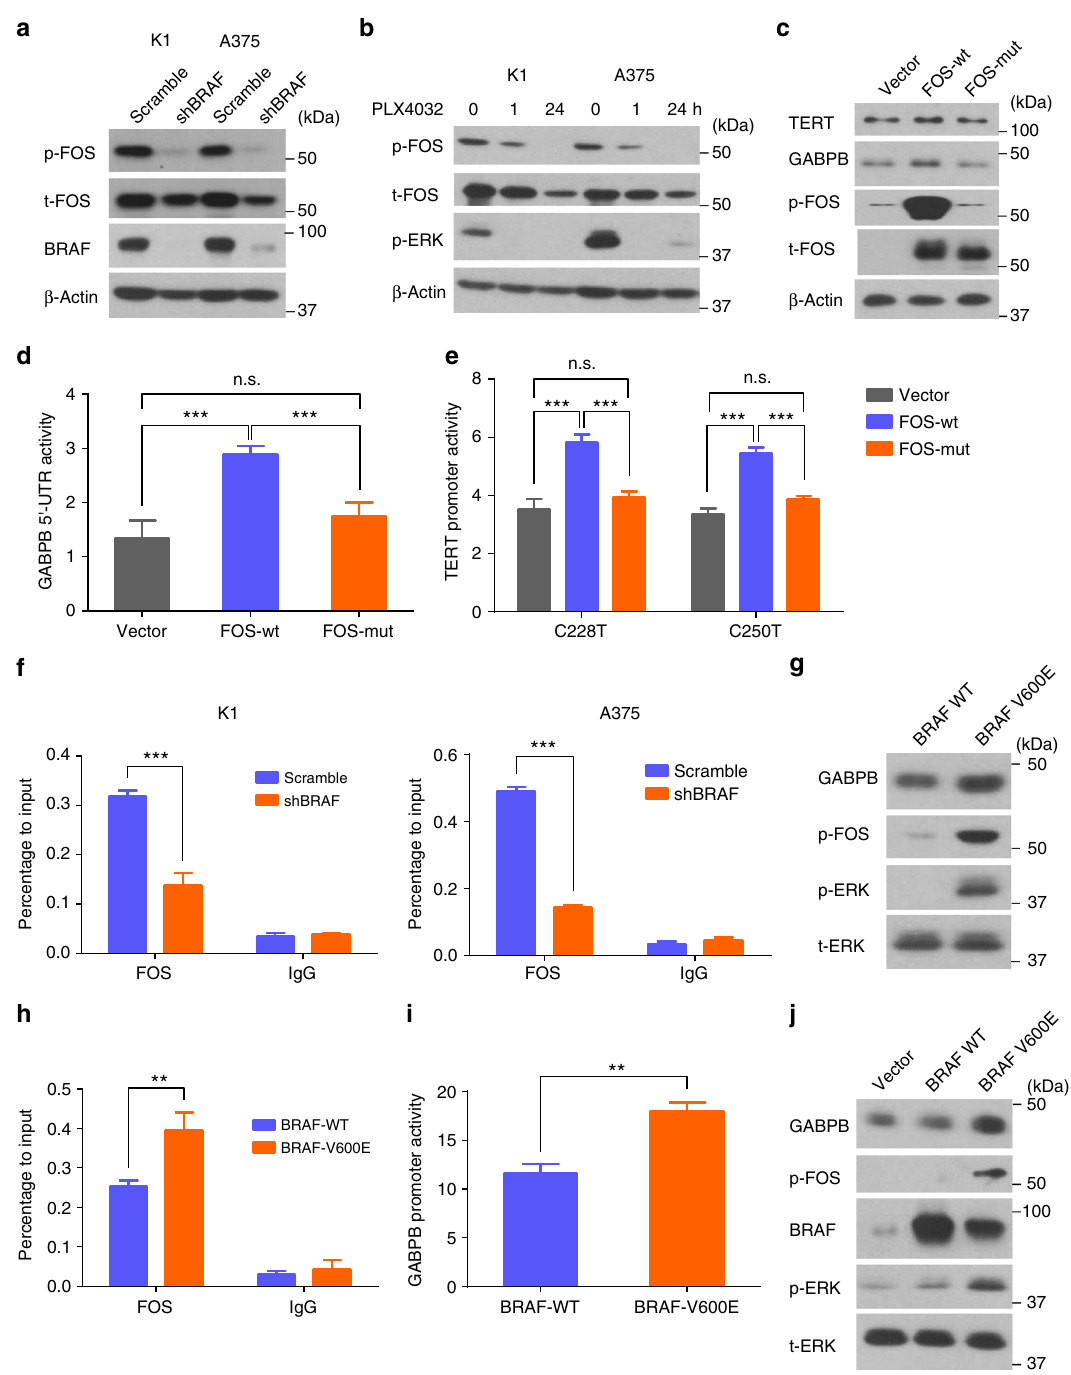
Fig. 6 BRAF V600E promoted FOS binding to GABPB by upregulating FOS phosphorylation. a Western blotting analyses for phosphorylated-FOS (p-FOS), total FOS (t-FOS), BRAF, and beta-actin in K1 and A375 cells with or without stable BRAF knockdown. b Western blotting analyses of p-FOS, t-FOS, p-ERK, and beta-actin in K1 and A375 cells treated with 0.5 μ M PLX4032 for 0, 1, and 24 h. c , d , e Effects of FOS phosphorylation on GABPB and TERT activation. c KAT18 cells were serum-starved for 24 h and transiently transfected with FOS wild-type (FOS-wt) or mutant (FOS-mut) bearing none of the potential ERK- targeted phosphorylation sites, followed by western blotting analysis for TERT, GABPB, p-FOS, t-FOS, and beta-actin. d KAT18 cells were transfected with FOS-wt or FOS-mut along with GABPB 5 ′ -UTR luciferase reporter and Renilla luciferase (pRL-TK) plasmids in the absence of serum for 24 h, and the luciferase activities were then measured. e KAT18 cells were transiently transfected with FOS-wt or FOS-mut, together with TERT promoter luciferase reporters harboring the C228T or C250T mutation, and pRL-TK for 24 h, followed by luciferase assays. f ChIP assay for FOS binding to the 5 ′ -UTR of GABPB in K1 and A375 cells. g Western blotting analyses for GABPB, p-FOS, p-ERK, and t-ERK in the parental and BRAF -V600E knock-in SW48 cells. h ChIP assay for FOS binding to the 5 ′ -UTR of GABPB in SW48 cells. i GABPB 5 ′ -UTR region-luciferase reporter assays in SW48 cells. j Wild-type (WT) BRAF and BRAF V600E were stably introduced to express in WRO cells, followed by western blotting analyses of the expression of GABPB, p-FOS, BRAF, p-ERK, and t-ERK after serum starving overnight. ** P < 0.01, *** P < 0.001, by two-tailed Student ’ s t test. n.s. not signi fi cant. All values represent the average ± standard deviation (SD) of triplicate samples and similar results were obtained in two additional independent